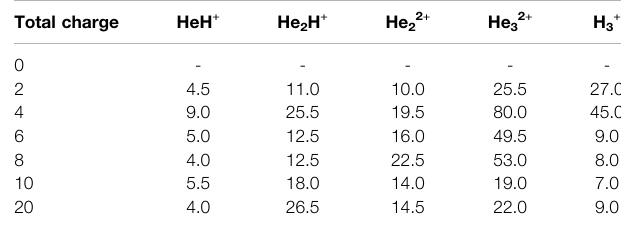
TABLE 3 | Time (in fs) of the fi rst appearance of different